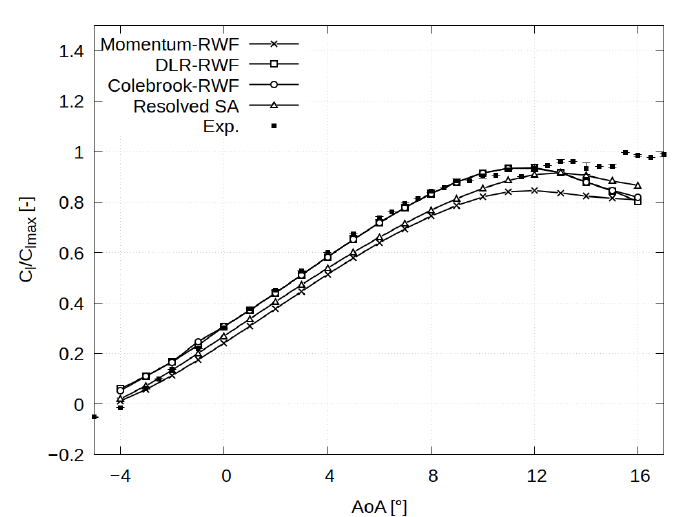
Figure 9. Case 1: C l vs AoA for different wall functions.